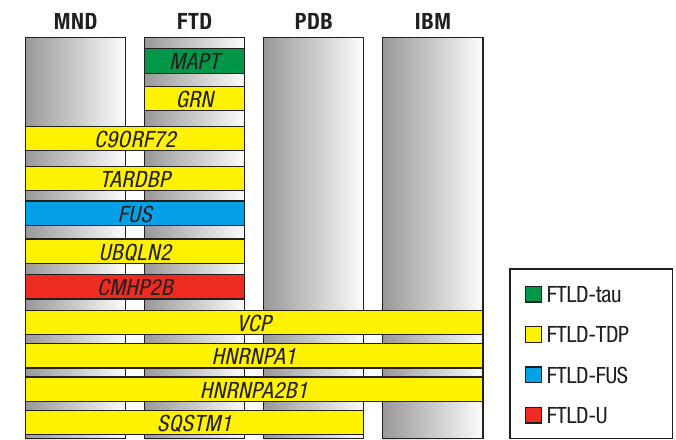
Figure 1. Genes associated with monogenic FTD with clinical and neuropathological correlations MND: motor neuron disease; FTD: frontotemporal dementia; PDB: Paget disease of the bone; IBM: inclusion body myositis. Each color refers to a FTLD subtype.